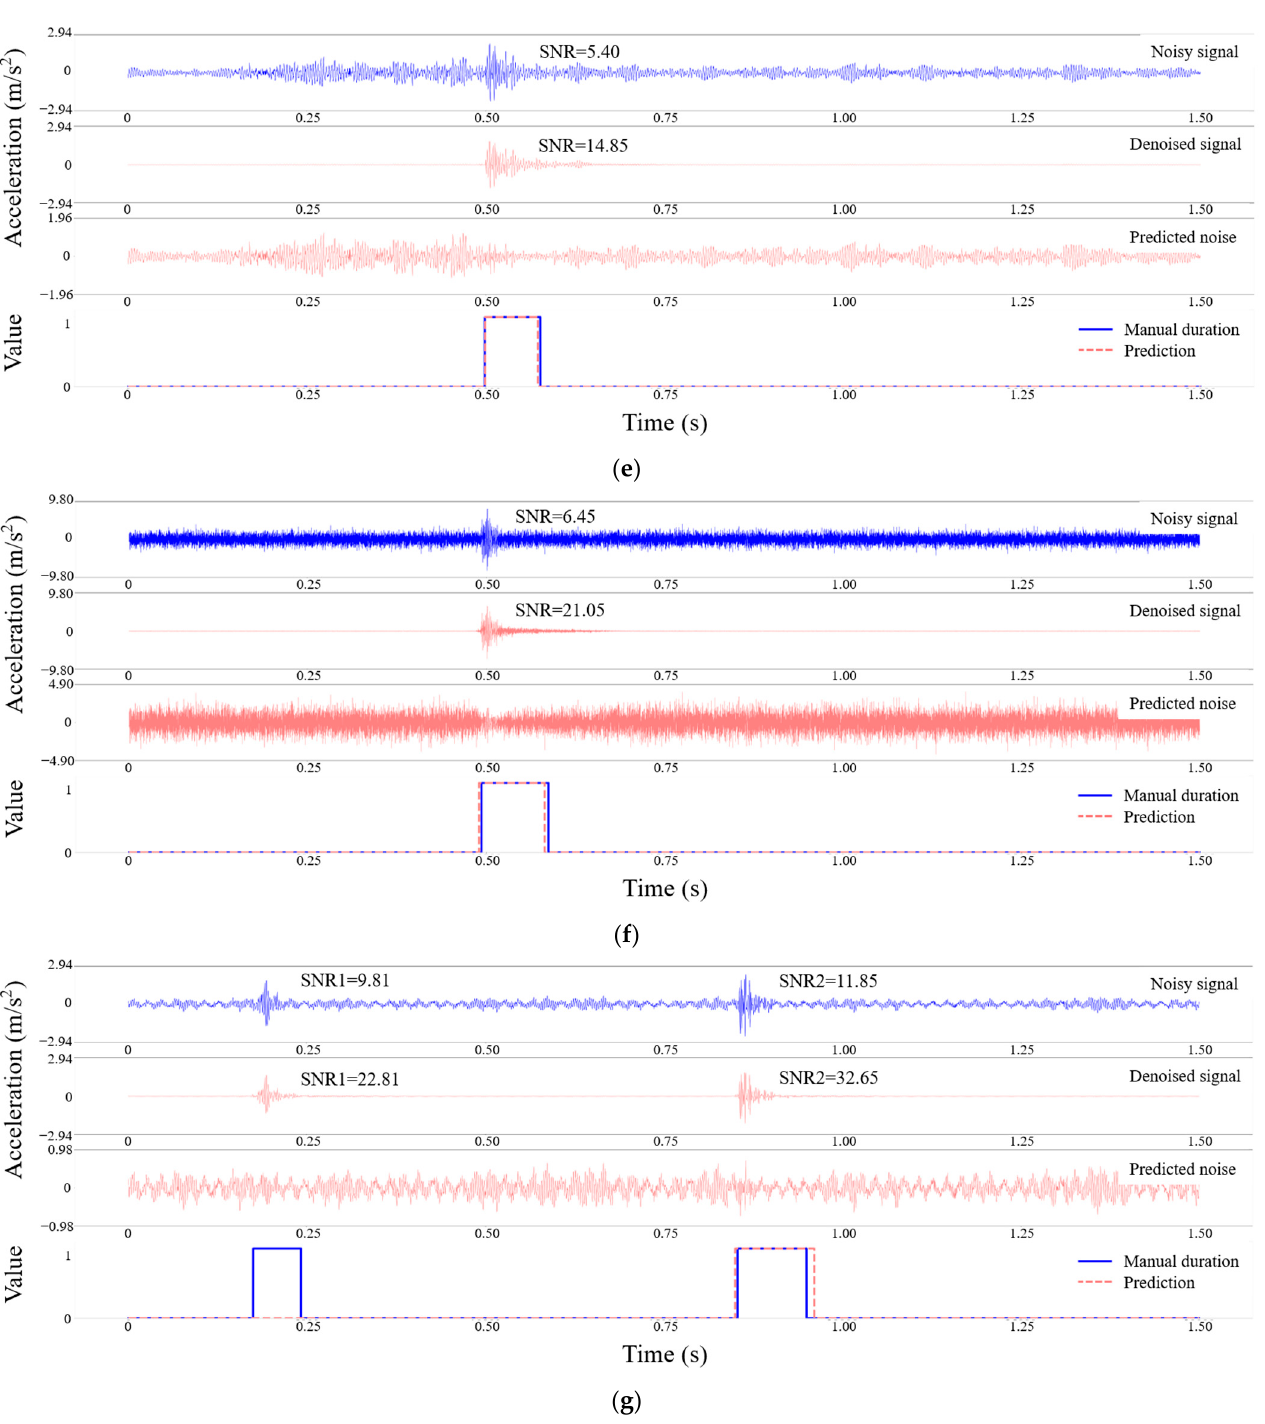
Figure 2. Visualization of denoising and detection performance of PDTN in the test set. ( a – g ) Each figure consists of four figures: from top to bottom, respectively, noisy signal, denoised signal, predicted noise, and manual and predicted durations.